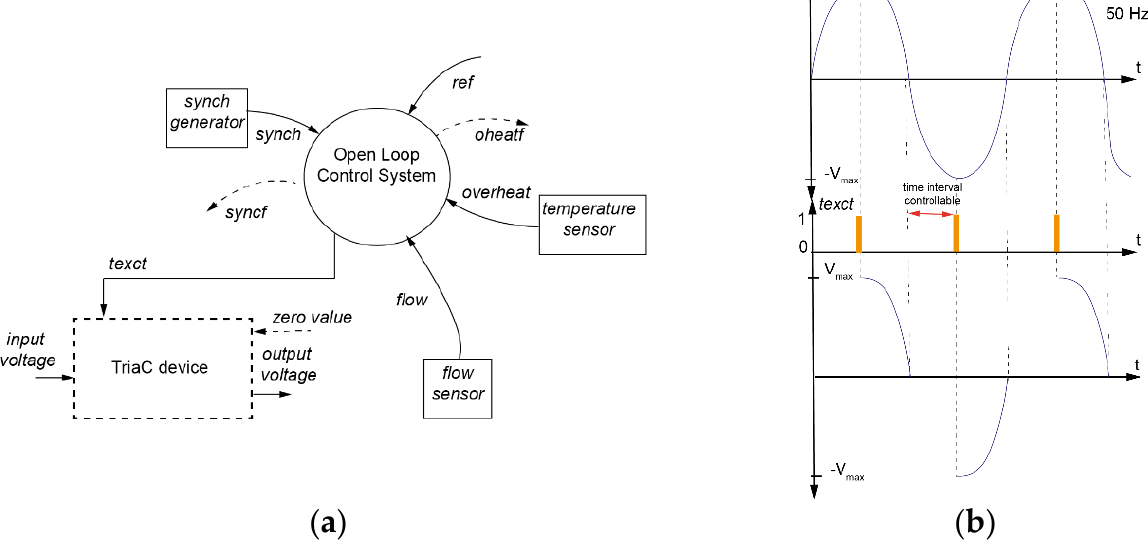
Figure 1. ( a ) System context diagram. ( b ) Graphical plot of the input voltage and the excitation signal of the TriaC device.